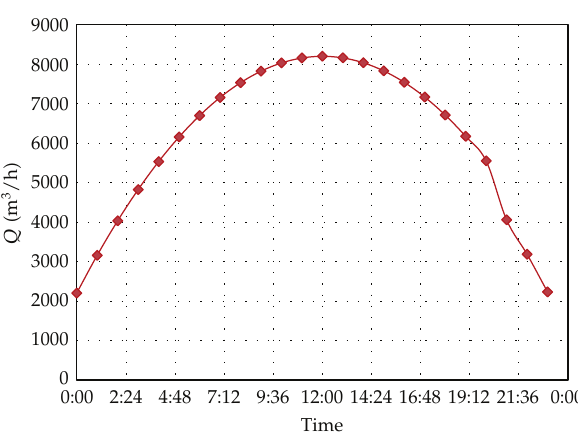
Figure 7: Daily variation curve of the entire flow demand.